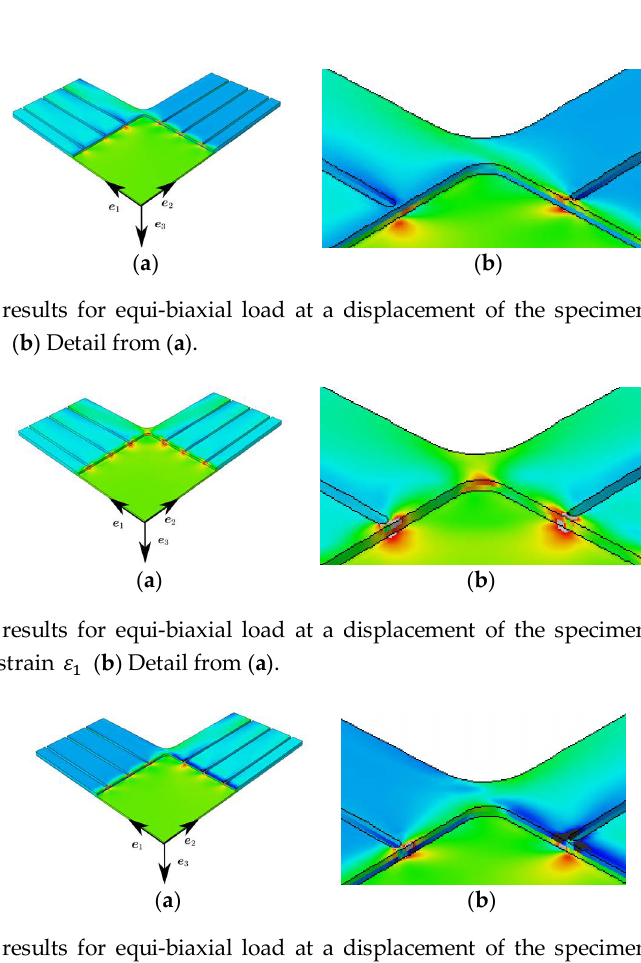
Figure 7. ( a ) FE results for equi-biaxial load at a displacement of the specimen arms of 0.2 mm, normal strain (cid:2013) (cid:2870)(cid:2870) ( b ) Detail from ( a